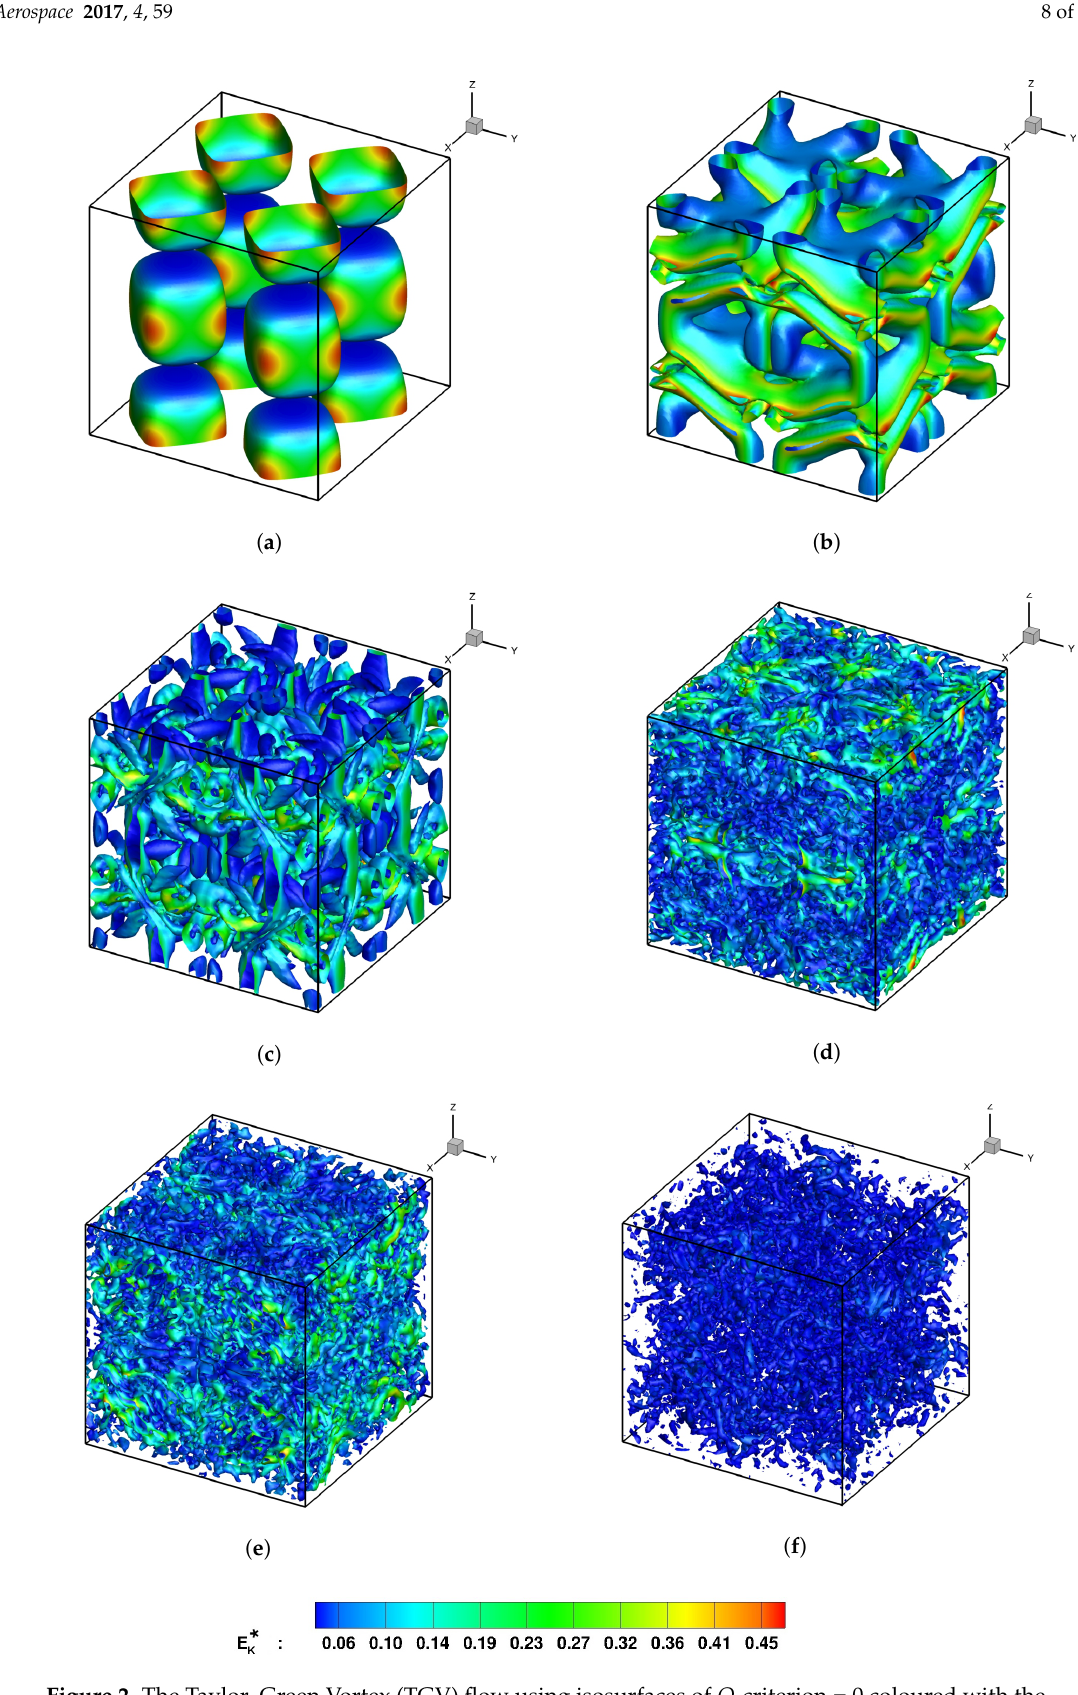
Figure 2. The Taylor–Green Vortex (TGV) flow using isosurfaces of Q -criterion = 0 coloured with the dimensionless kinetic energy obtained through the third-order MUSCL scheme with the Kim and Kim slope limiter (M3-KK) on a 96 3 grid. ( a ) t* = 0; ( b ) t* = 4; ( c ) t* = 8; ( d ) t* = 20; ( e ) t* = 30; ( f ) t* =